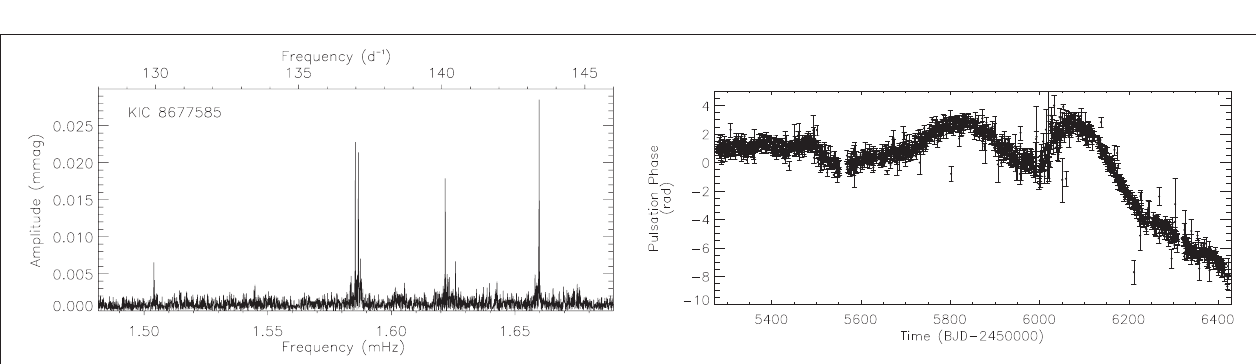
FIGURE 3 | Each row in the figure corresponds to a different star. From top to bottom: KIC6631188, KIC7018170, KIC10685175, and KIC11031749. (Left) Amplitude spectra of the LC light curve. (Right) Phase variability of the principal mode in the star, as shown in the left column. The top panels show KIC11296437 and the bottom panel shows KIC11409673.